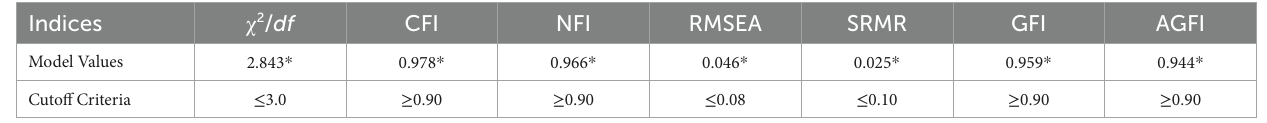
TABLE 5 Model fit indices of model